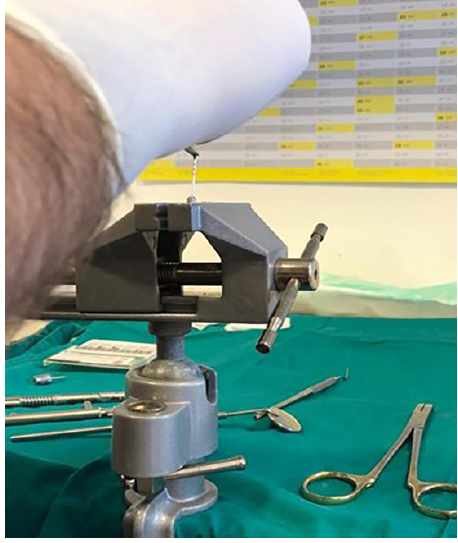
Figure 8. Sampling with paper points.